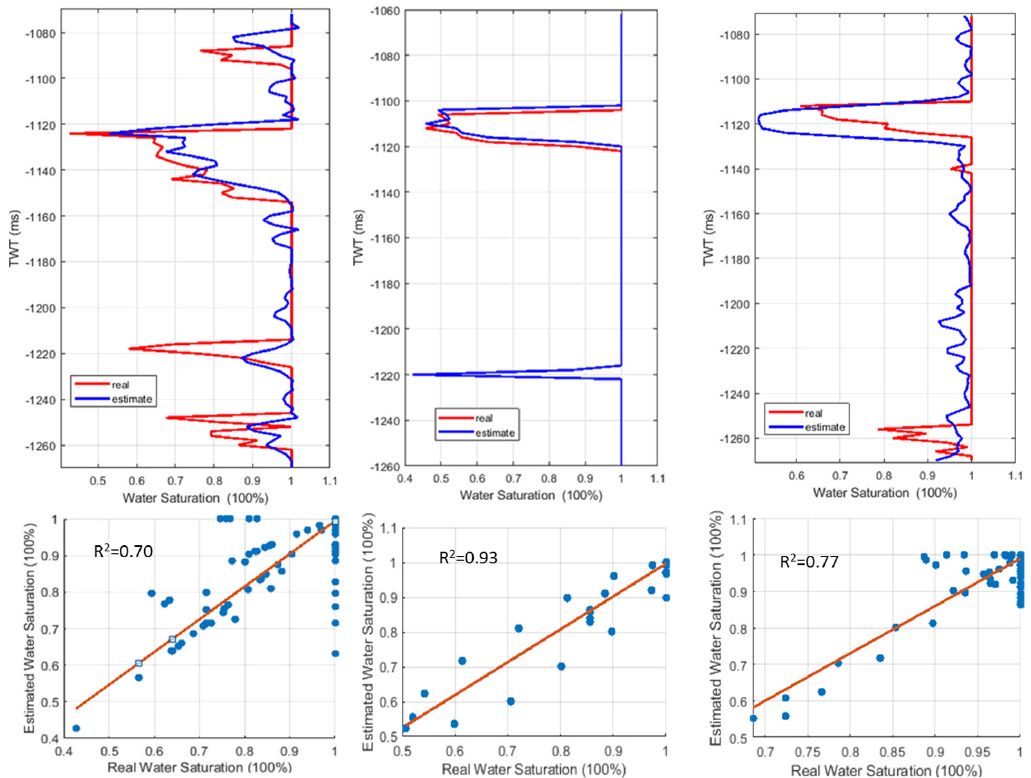
Figure 14. Overlay (upper row) and cross plots (lower row) of estimate and real water saturation at well locations. From left to right: (first column) Well 3 (blind), (second column) Well 1 (control), (third column) Well 2 (blind). Both the estimated and real data are smoothed. Red lines in the cross plot are the best line between the real and estimated water saturation.